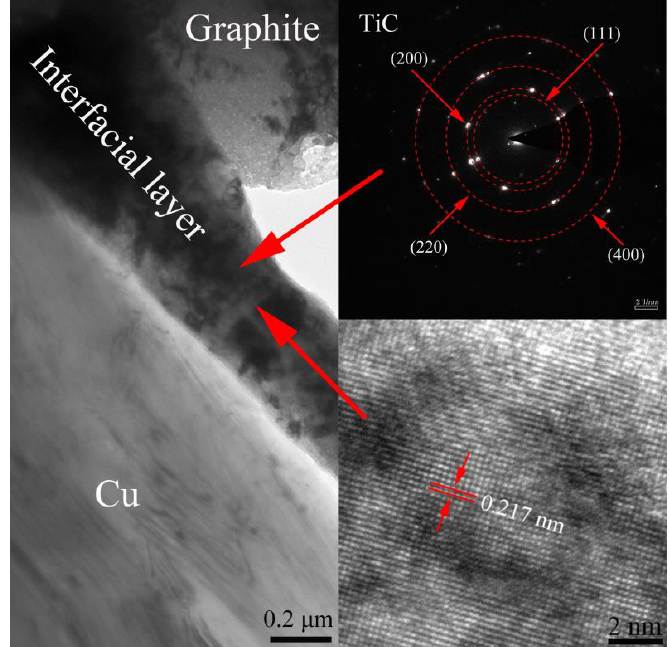
Figure 7. TEM image with the corresponding selected area electron diffraction pattern and HRTEM lattice image of the TiC interfacial layer.